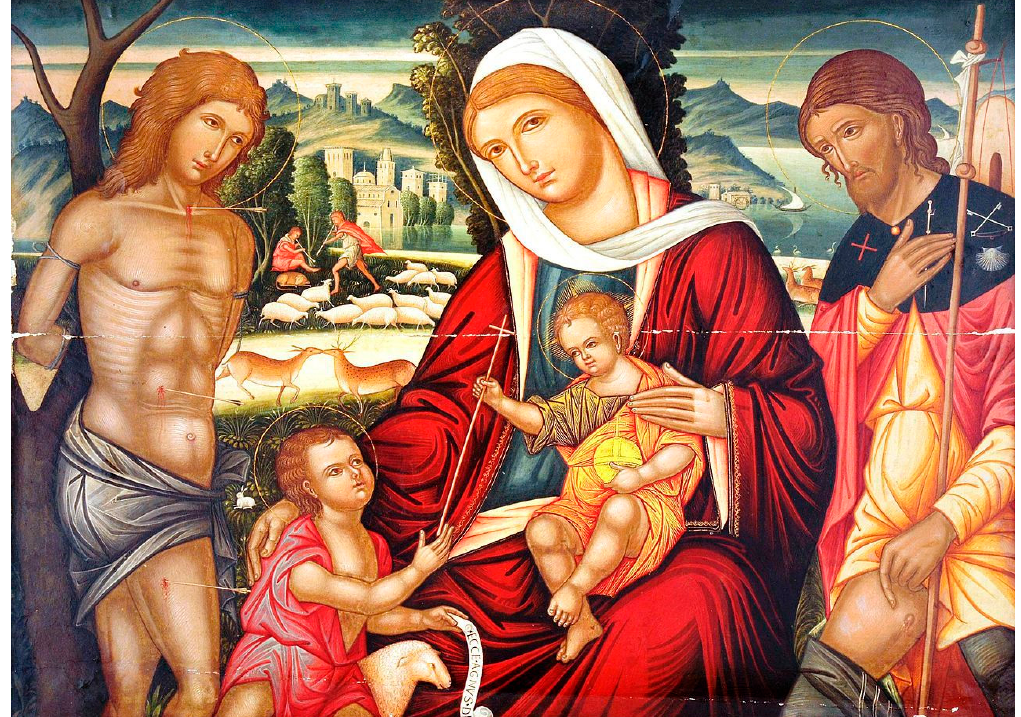
Figure 8. Permeniates (attr.), Madonna and Child with the Infant Saint John and Saints Sebastian and Roch, private collection (image in the public domain).